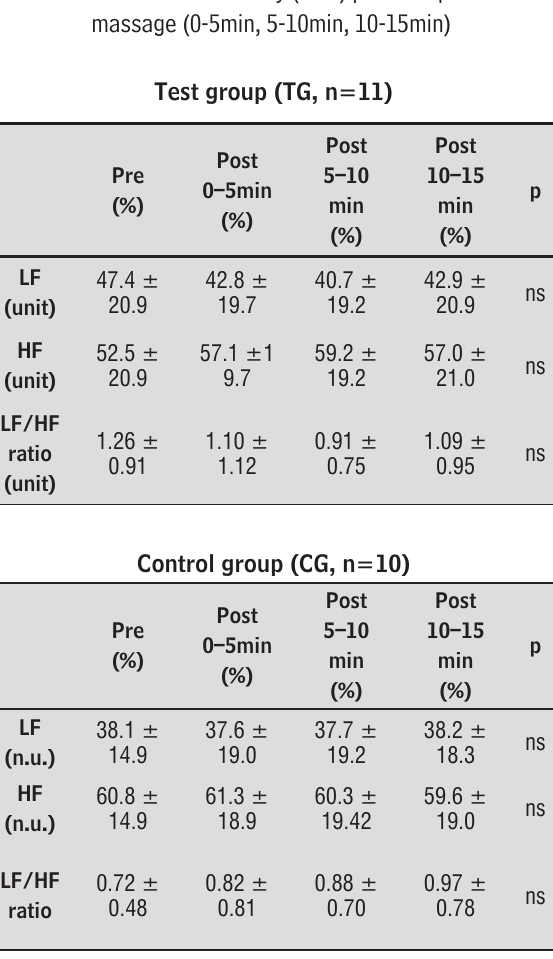
Table 2 - Mean values of low frequency (LF) and high fre- quency (HF) calculated in standard units, from the analysis of the frequency domain (FD) of heart rate variability (HRV) pre- and post-classic massage (0-5min, 5-10min, 10-15min)